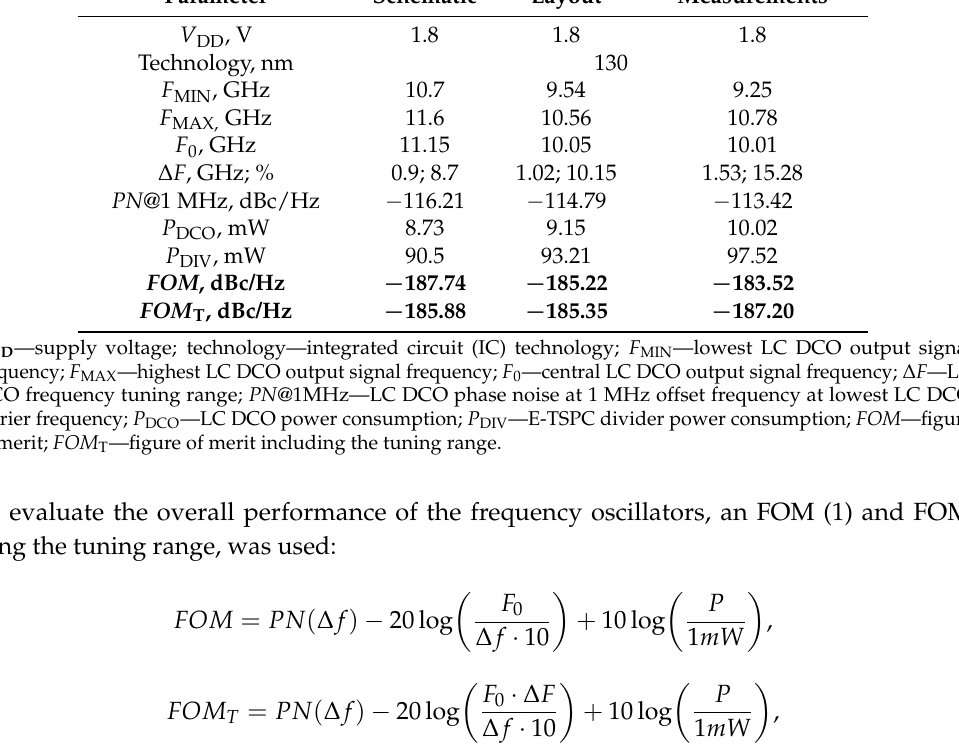
Table 1. Main parameters of the proposed LC DCO and E-TSPC divider. Parameter